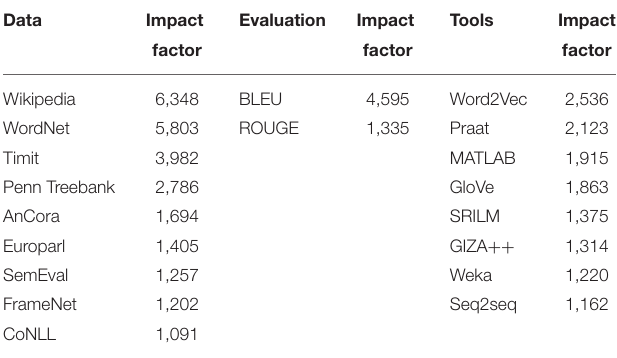
TABLE 31 | Language resources impact factor (data, specifications, and